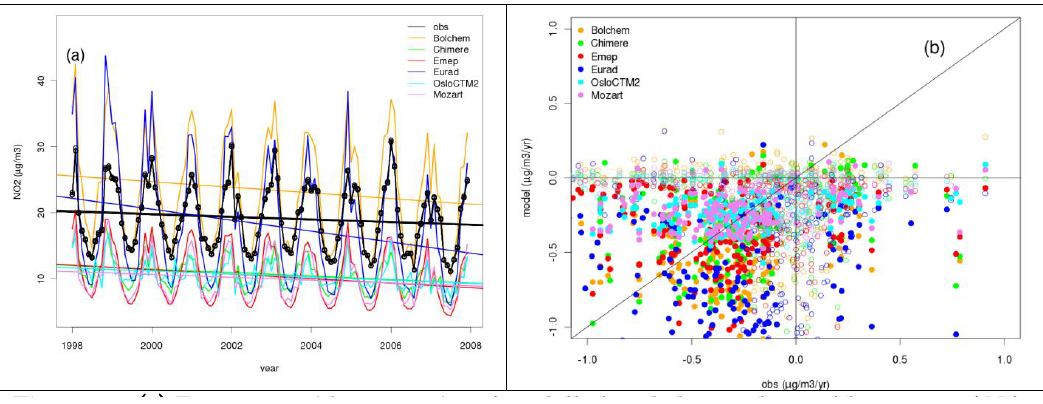
Figure 7: Modelled NO 2 trend (µg/m3/yr) for each CTM and at each grid point computed on the basis of monthly means of daily means over the 1998-2007 period with a linear least square fit of de-seasonalised values.